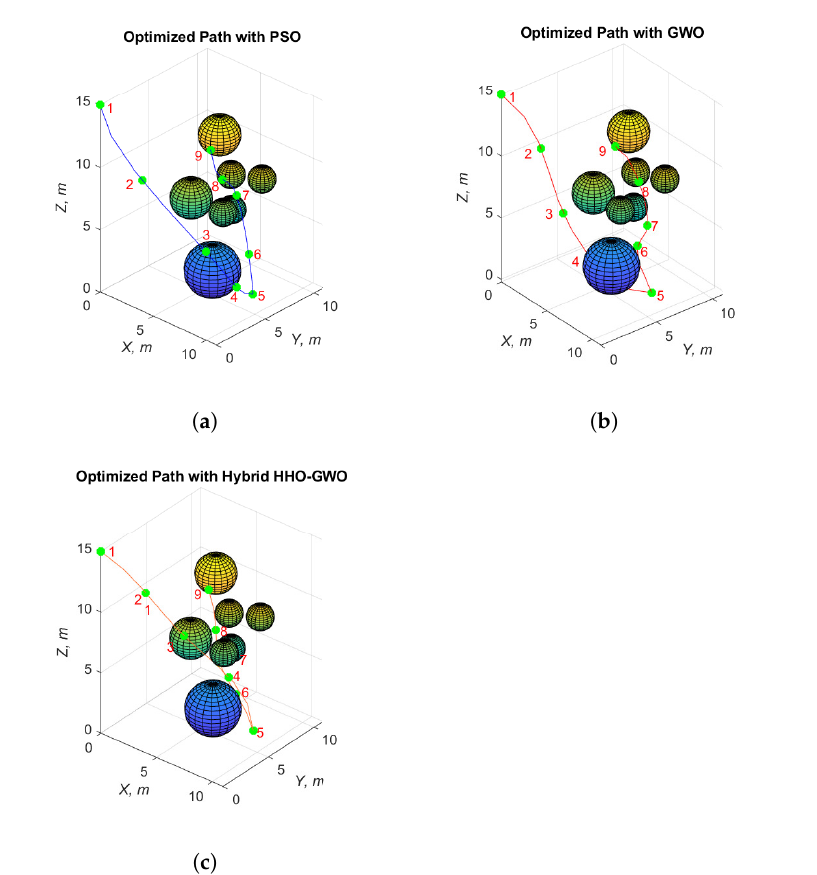
Figure 11. The optimized path for Map 3 ( a ) using PSO, ( b ) using GWO, and ( c ) using hybrid